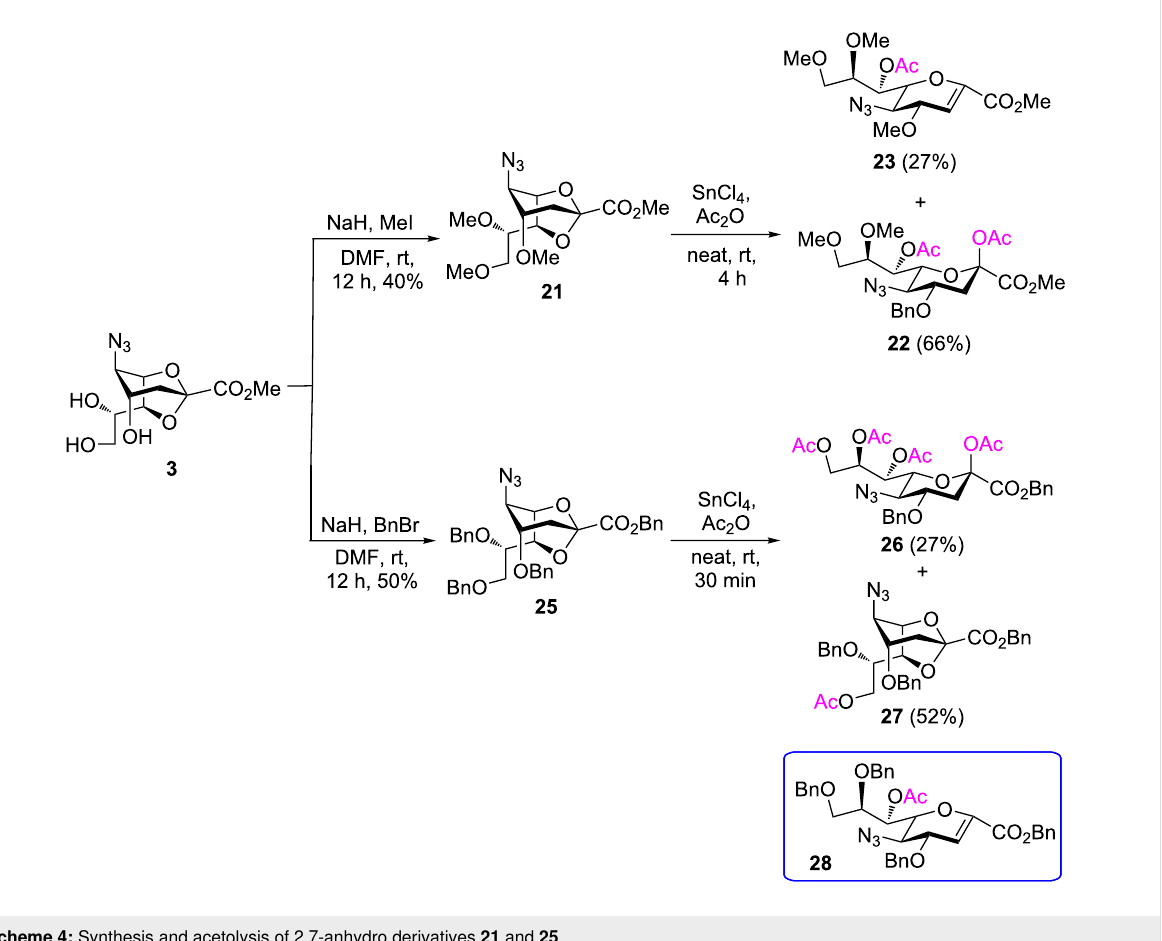
Scheme 4: Synthesis and acetolysis of 2,7-anhydro derivatives 21 and 25